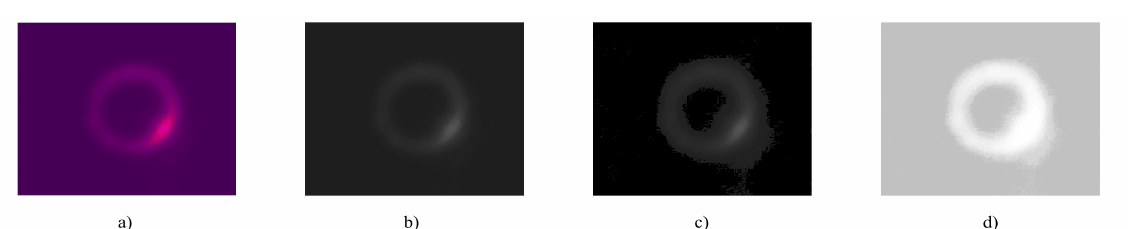
Figure 5. ( a ) Original image, ( b ) Grayscale image, ( c ) Grayscale image with background set to 0, and ( d ) Image after histogram